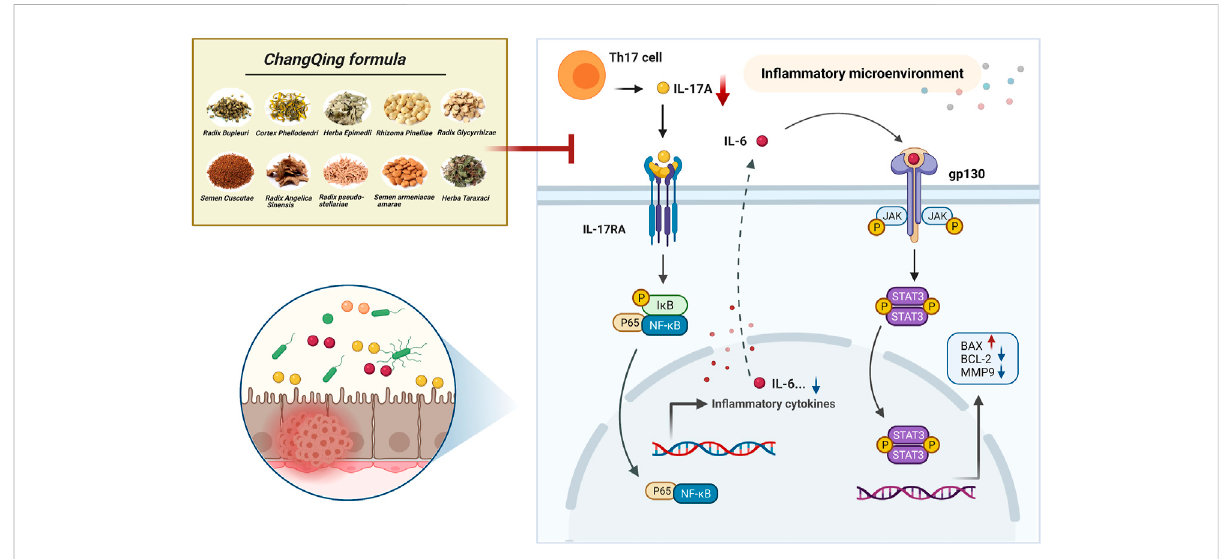
FIGURE 8 Diagram showing a hypothesized mechanism by which Chang Qing formula is effective in the treatment of colitis-associated colon